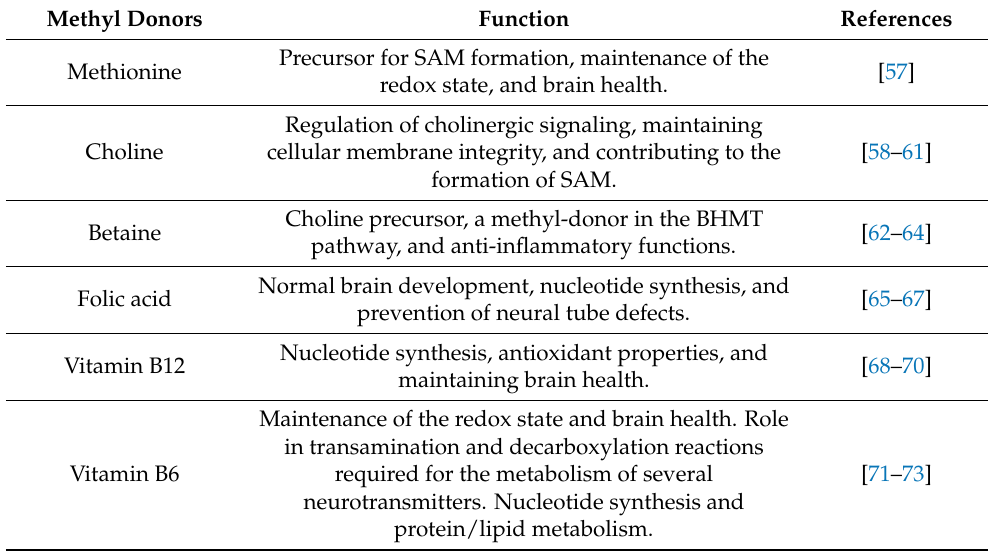
Table 1. This table summarizes the functions of methyl donors that contribute to the one- carbon